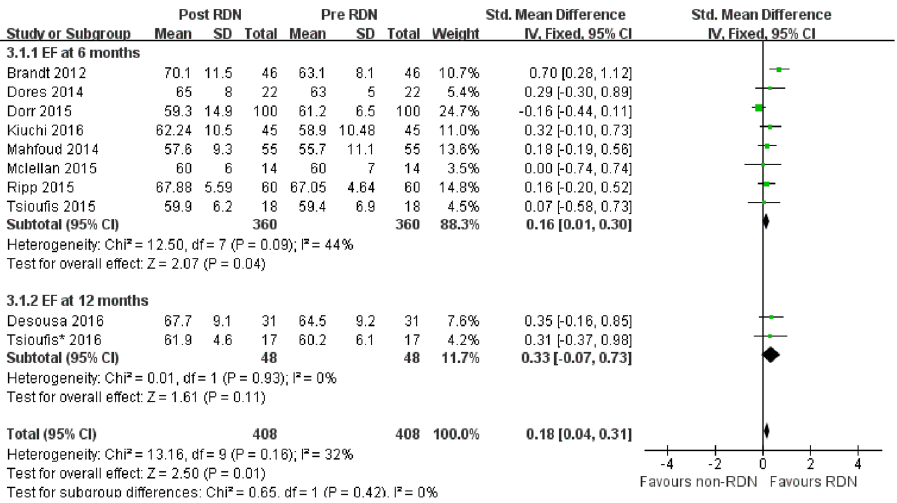
Figure 6. Forest plot of RDN changing EF in observational studies, stratified by follow up